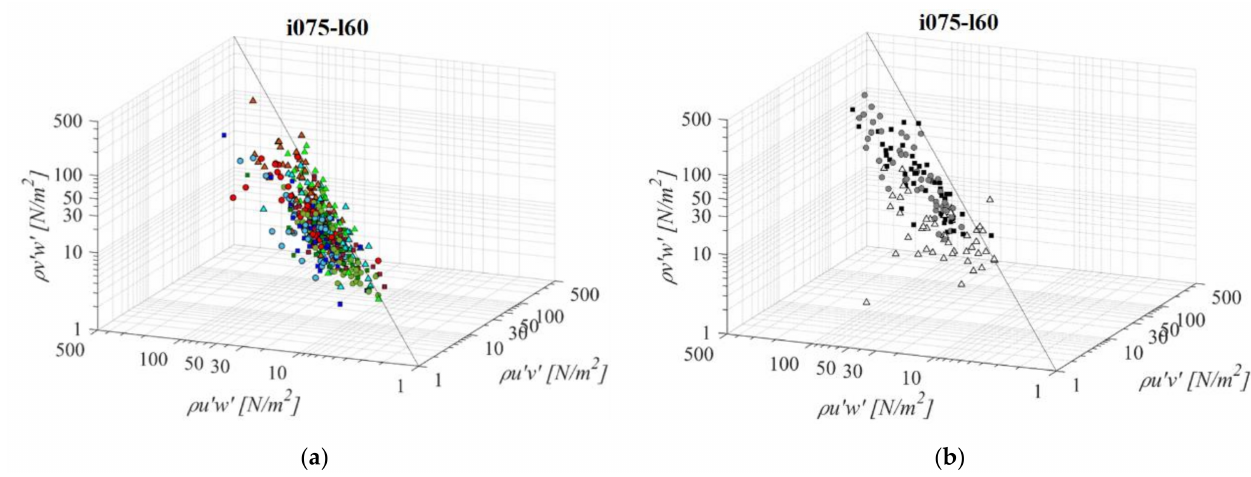
Figure 12. 3D scatterplot of concurrent RSS components for the i075l60 fishway configuration: ( a ) pool-orifice type fishway and ( b ) vertical slot fishway.